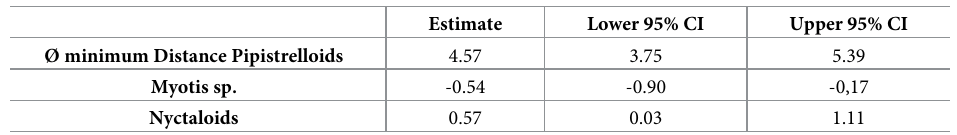
Table 3. Test statistics for Fig